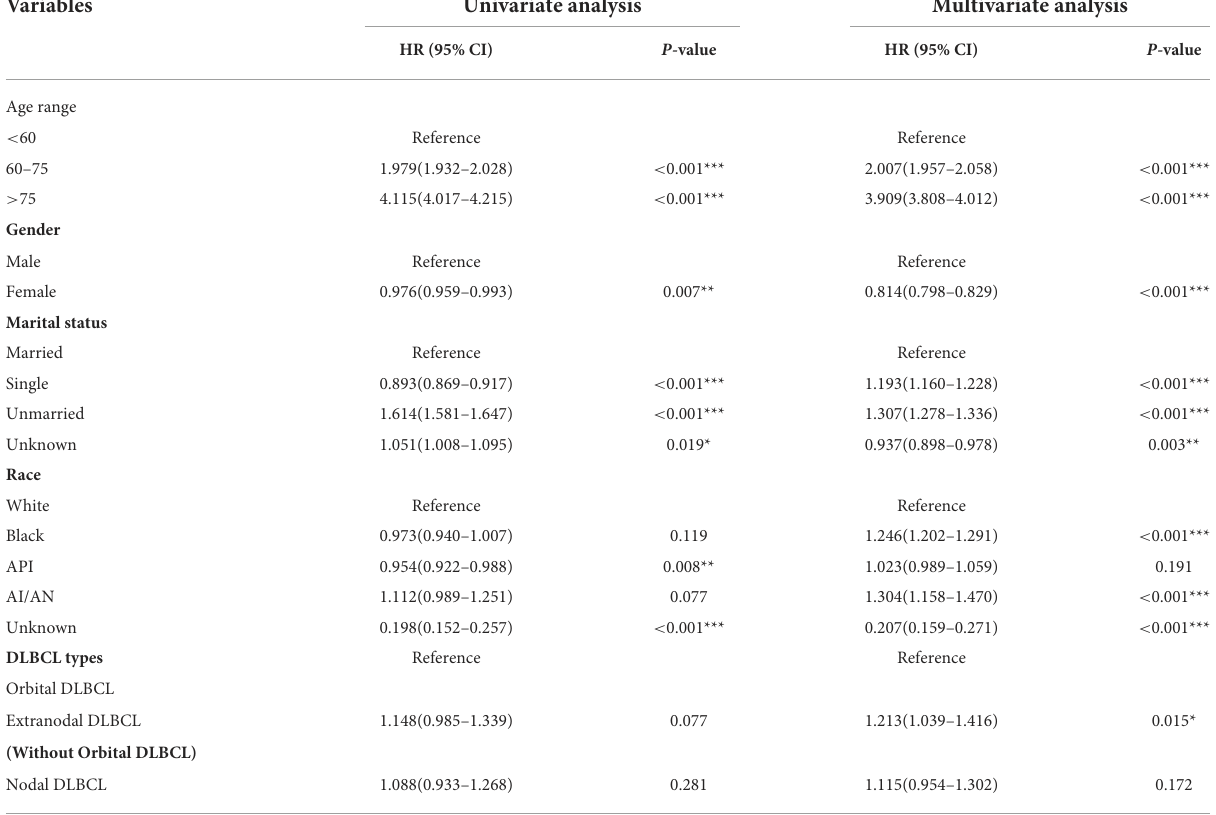
TABLE 2 Univariate and multivariate analysis of factors related to the risks of OS for patients with DLBCL in the SEER Program database from 2000 to 2017.